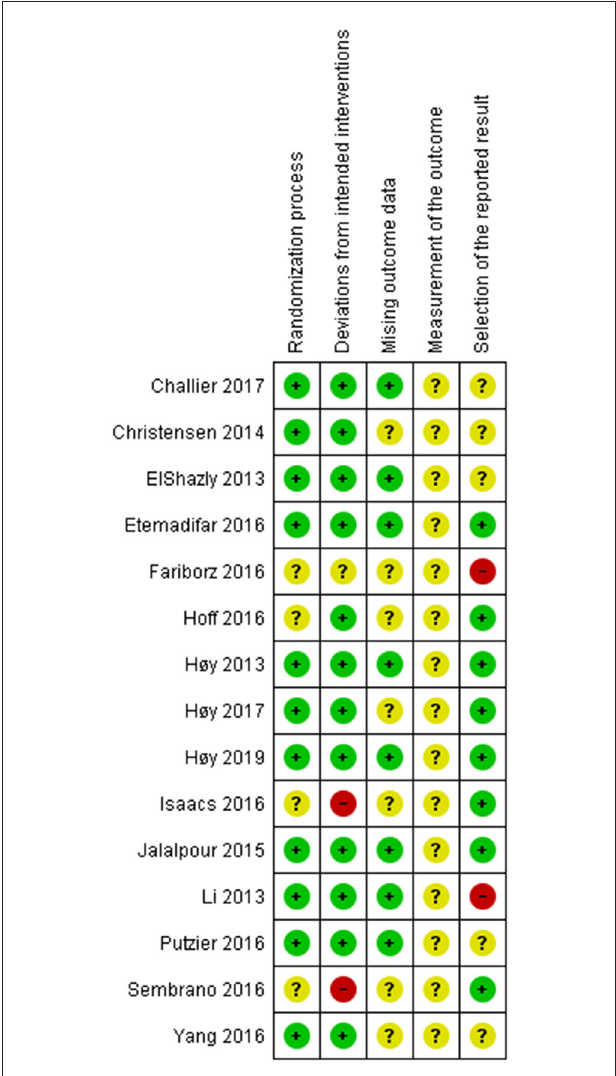
FIGURE 2 | The risk of bias of each included RCT. Low risk is presented as green dot, some concerns as yellow dot, and high risk as red